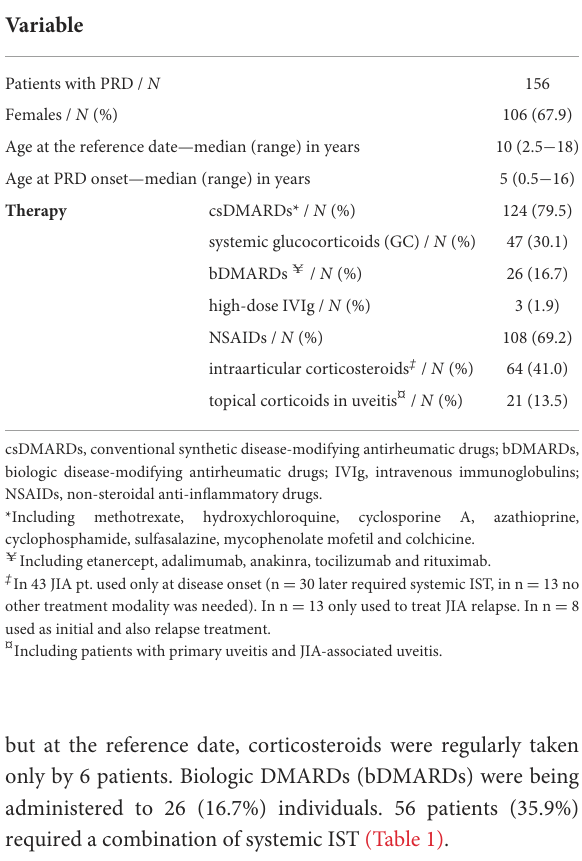
TABLE 1 Patients’ characteristics and treatment modalities during rheumatological